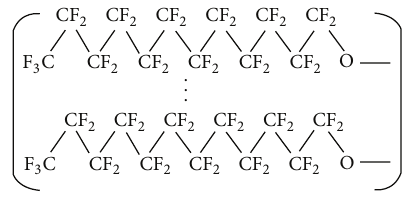
Figure 5: Molecular structure of SURFLON S-386.